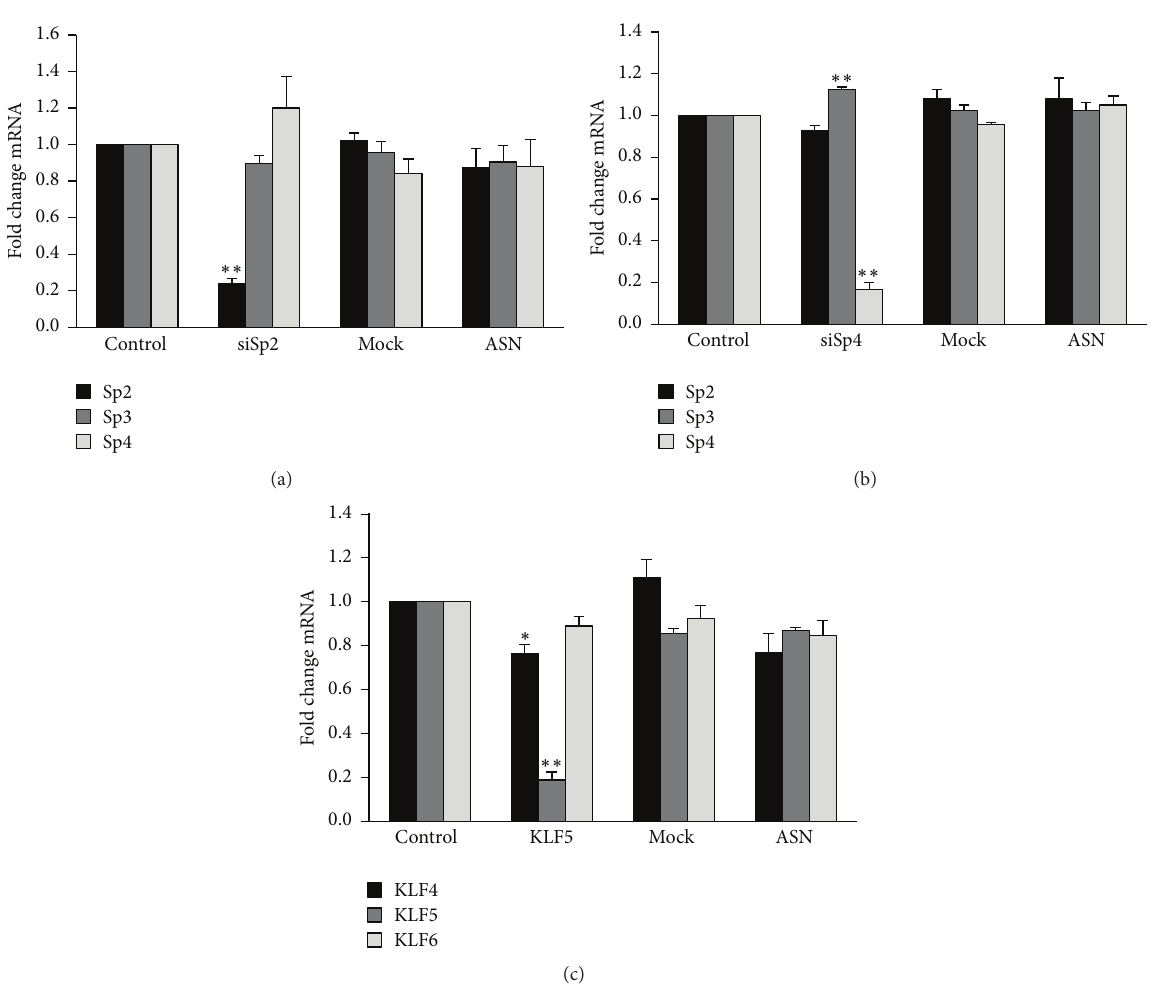
Figure 6: siRNA specificity in Sp2, Sp4, and KLF5 knocked HUVECs. mRNA expression of Sp2, Sp3, and Sp4 in HUVECs treated with siRNA targeting (a) Sp2 and (b) Sp4. (c) mRNA expression of KLF4, KLF5, and KLF6 in HUVECs treated with siRNA targeting KLF5. Mock = transfection reagent only; ASN = transfection with “All Star Negative” control siRNA. The results are presented as mean values ± SEM of three independent experiments. The statistical evaluation was performed using paired Student’s 𝑡 -test.